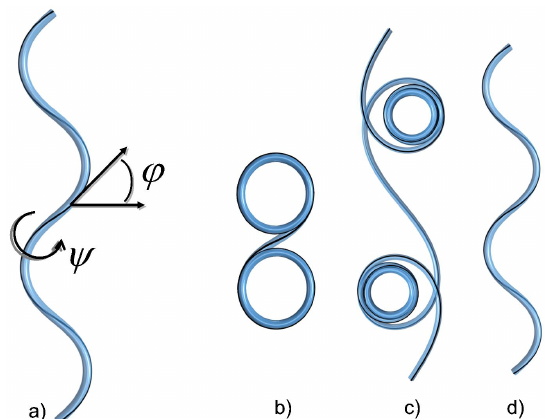
Figure 6. ( a ) Schematic squeelix with the angle ϕ that is slaved to the twist angle ψ given by the line in black; ( b ) typical shape of a squeelix for γ = 1 (see Equation (19)) with a single twist-kink; ( c ) a squeelix in the dilute regime of twist-kinks with γ = 0.997; ( d ) a squeelix in the dense regime of twist-kinks with γ = 0.52. The ground states (b), (c) and (d) are from